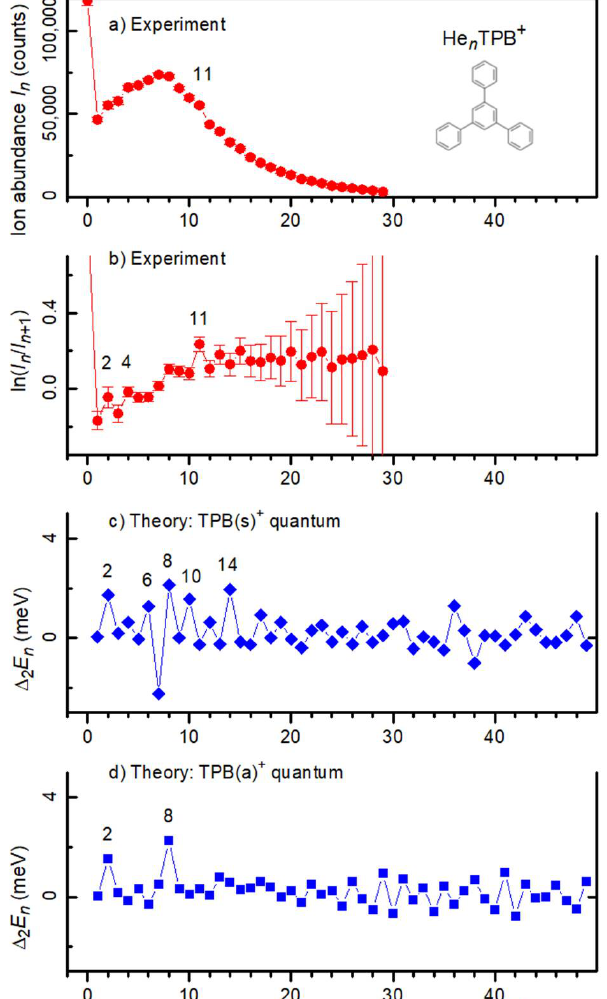
Figure 5. Panel ( a ): Ion abundance I n of He n TPB + versus size n . Panel ( b ): The first derivative of the logarithm of I n . Prominent local anomalies are labeled. Panels ( c , d ): The second derivative of the energy E n of He n TPB + calculated from the quantum virial energy for the symmetric (s) and asymmetric (a) isomer, respectively.